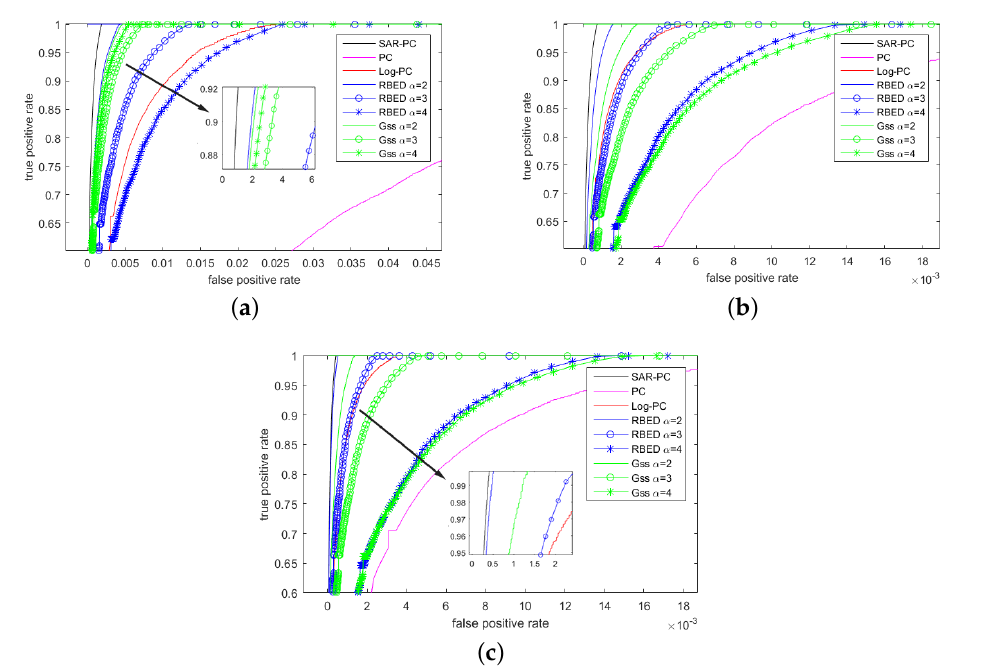
Figure 10. ( a ) Receiver operating characteristic (ROC) curves on one-look simulated SAR image (Step); ( b ) ROC curves on three-look simulated SAR image (Step); ( c ) ROC curves on six-look simulated SAR image